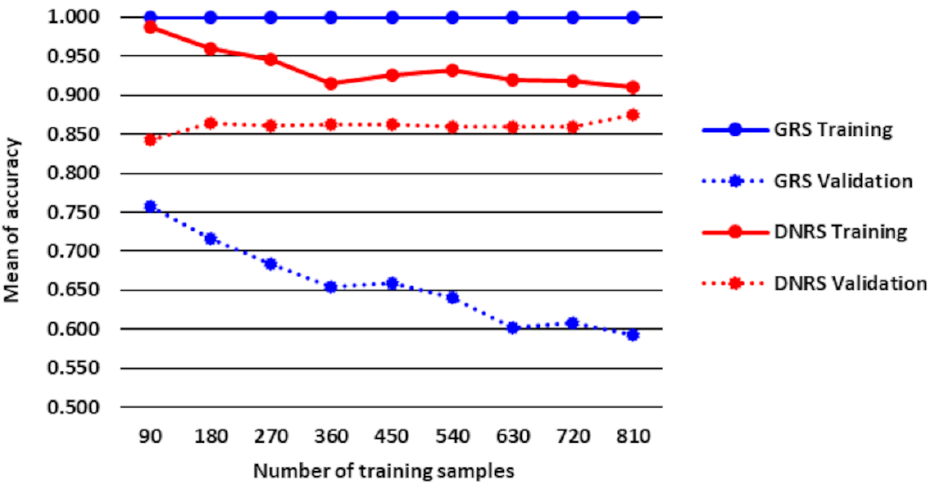
Figure 6. Learning curves for classification using the Raisin 10-fold cross-validation dataset with attributes 4, 6, and 7. Table 9. Total confusion matrix of 10-fold cross-validation of classification results with the GRS with 90 samples of training data using attributes 4, 6, and 7 of the Raisin dataset.